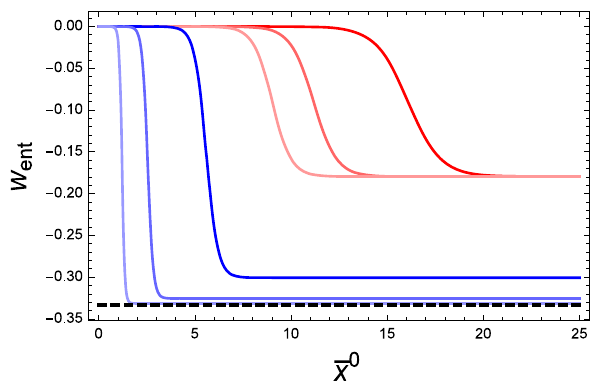
Fig. 4 The effective barotropic index w ef f against the rescaled proper time of the comoving observer ¯ x 0 . Red lines represent models which differs with Λ only. Blue lines represent models which differs with A parameter only. All models with F = 0 are represented by the dashed black line in the above figure (regardless the value of other